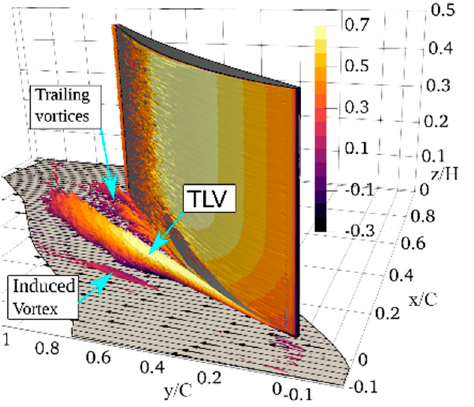
→ Figure 15. Vortical structure ( λ 2 ( (cid:104) v (cid:105) ) = − 2 ) for the linear compressor cascade at Re c = 3 · 10 5 with relative motion between blade and endwall. Black lines with arrows at the bottom denote the endwall motion.